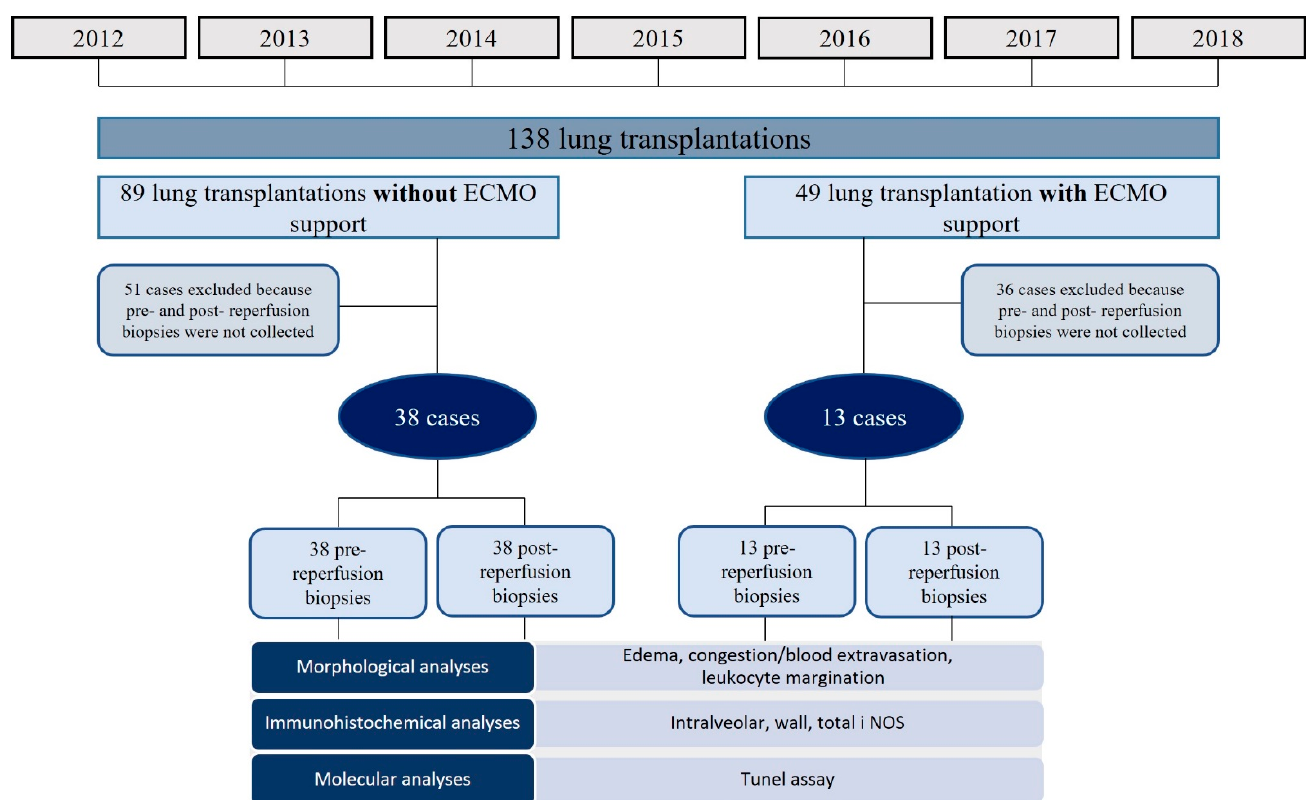
Figure 1. Flow chart describing the study population and design.